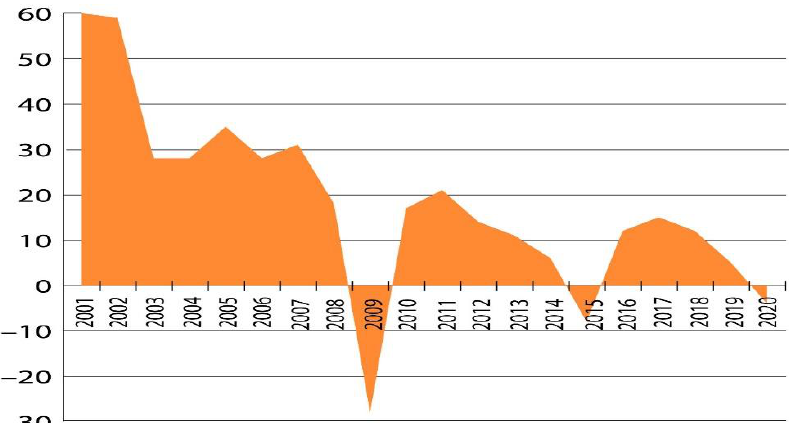
Figure 1. The Russian advertising market dynamics in 2001–2020, %% for previous period (year) (AKAR 2021b).